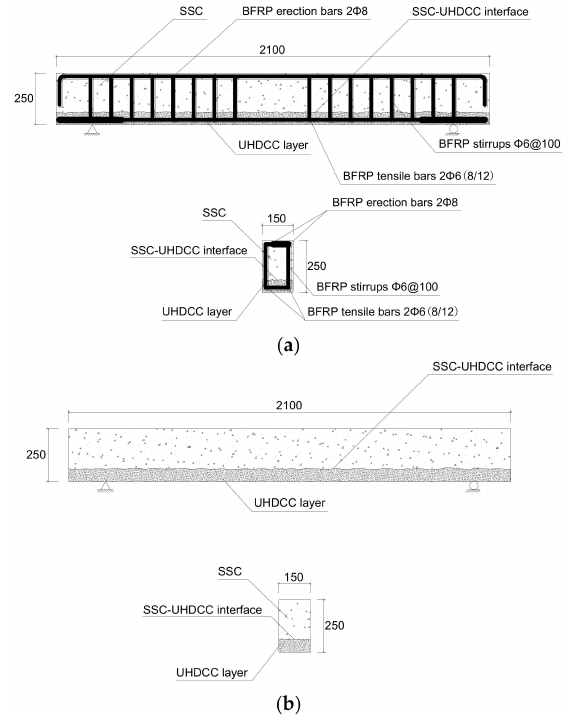
Figure 4. Details of sea sand ans seawater concrete (SSC)-ultra-high ductile cementitious composites (UHDCC) specimen (unit, mm). SSC-UHDCC beams without BFRP